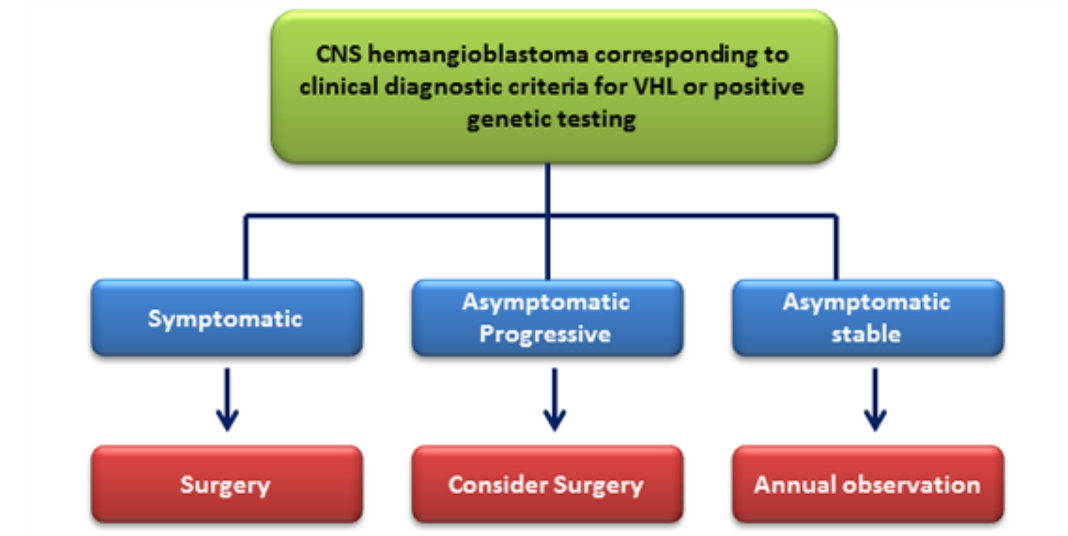
Figure 3. Clinical management of